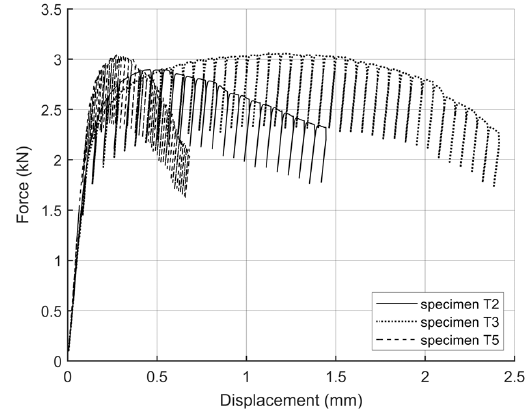
Figure 2. Force ‐ displacement test records for selected specimens. Figure 2. Force-displacement test records for selected